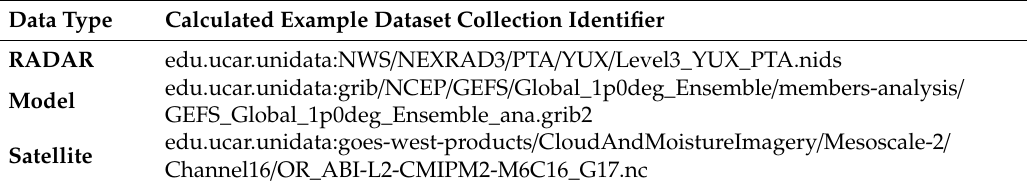
Table 4. Collection identifiers for the example dataset IDs. They are calculated by removing temporal information and prefixing an authority namespace